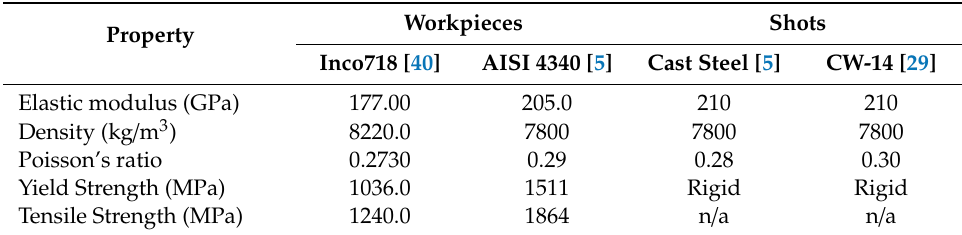
Table 1. Mechanical properties of shots and Targets